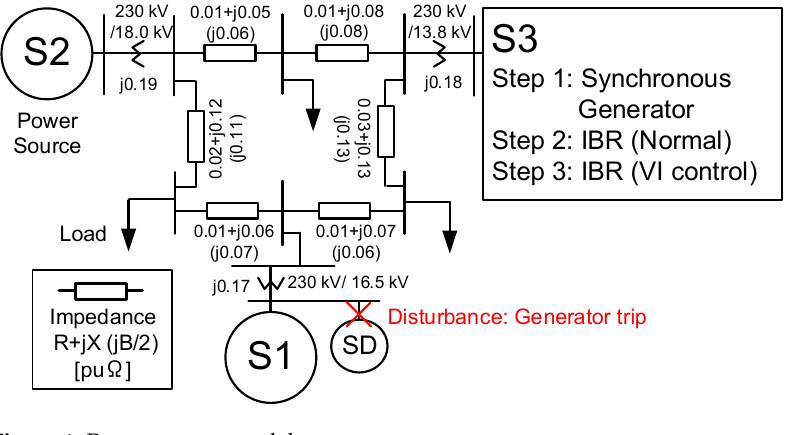
Figure 1. Power system model.